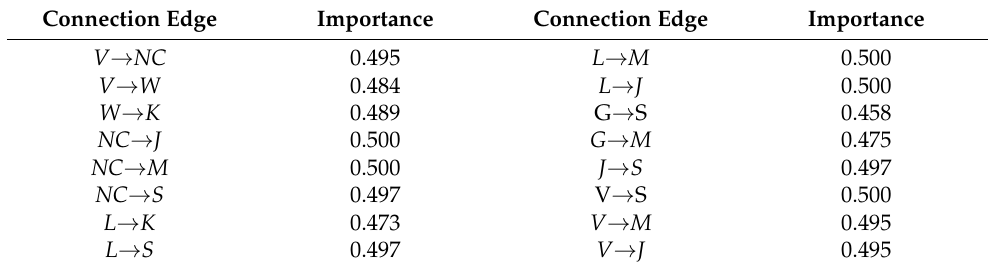
Table 11. Importance of each connection edge of machining center.